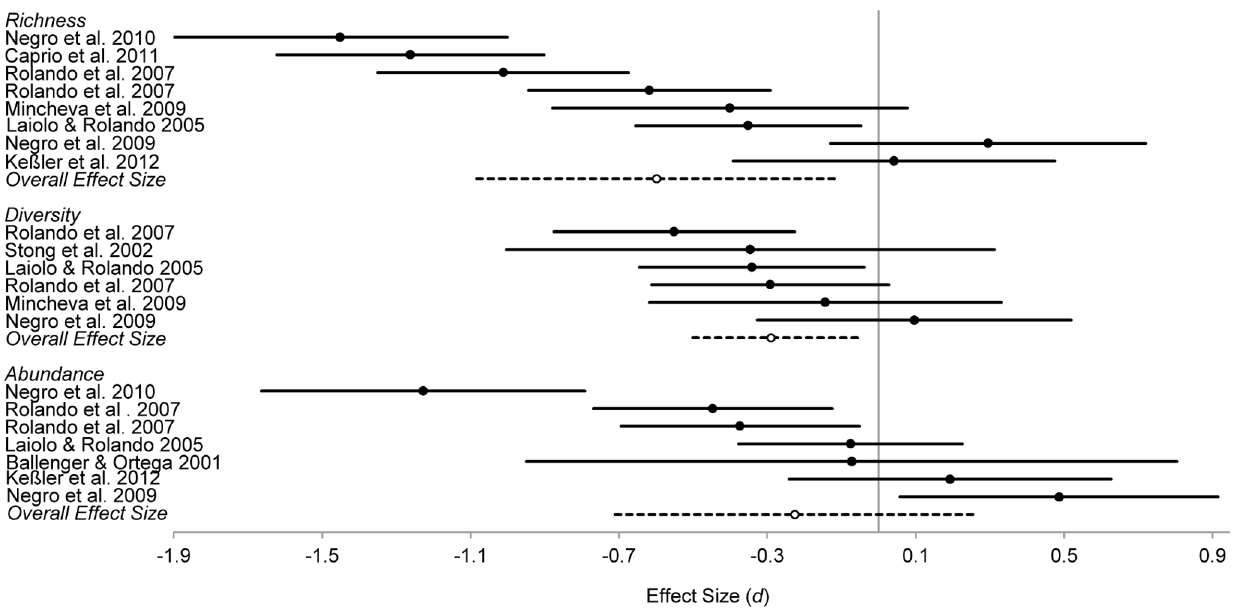
Figure 6. Overall and individual study effect sizes ( ± 95% C.I.) of winter recreation on fauna ( d ). Weighted effect sizes were calculated for meta-analyses on measures of richness, diversity and abundance.